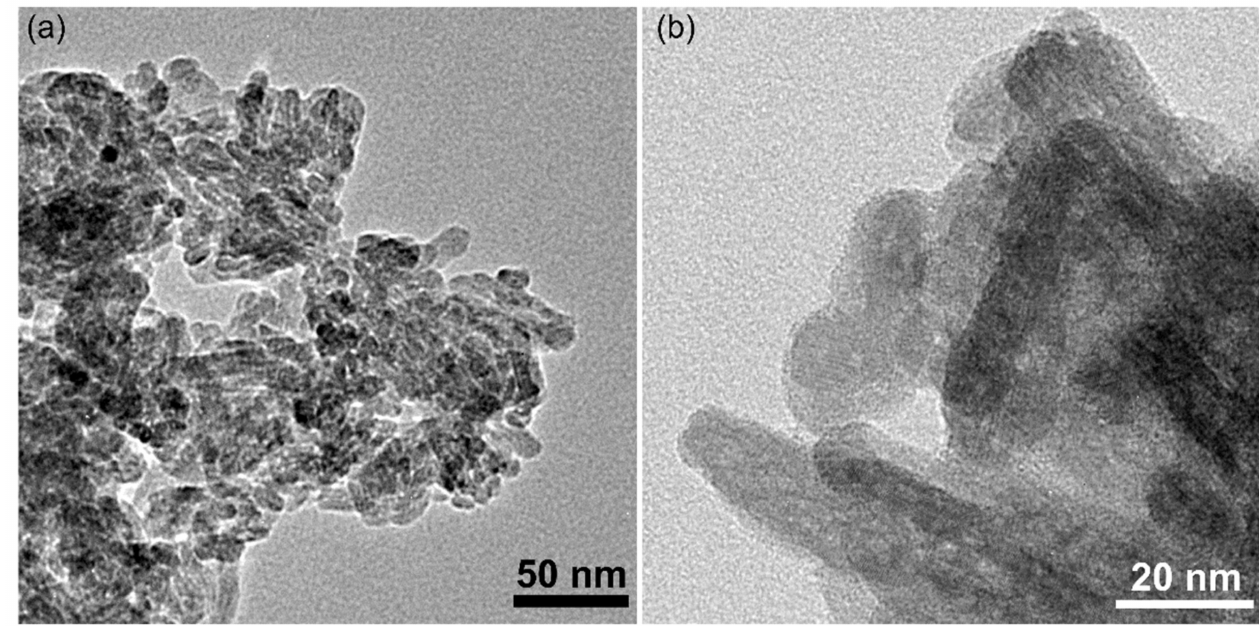
Figure 4. Transmission electron microcopy (TEM) ( a ) and High resolution transmission electron microcopy (HRTEM) ( b ) image of HAp-CTAB nanocomposites.